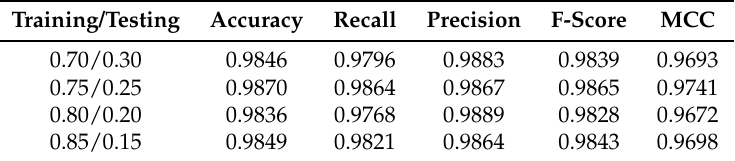
Table 6. Performances with different proportions of training and testing sets on the benchmark dataset.